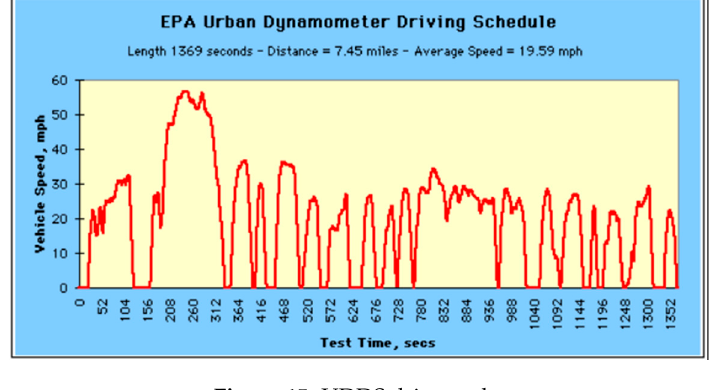
Figure 15. UDDS drive cycle. Appl. Syst. Innov. 2020 , 3 , x FOR PEER REVIEW